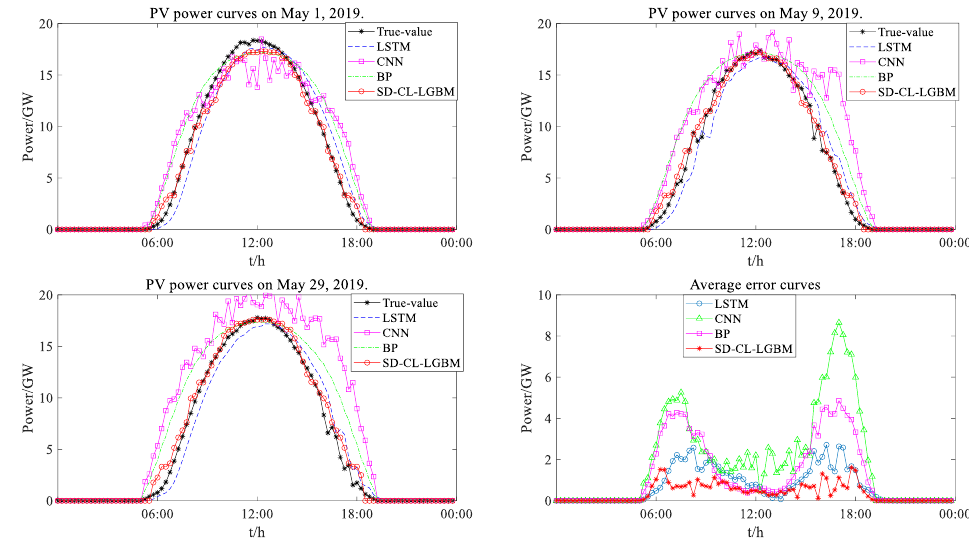
Figure 12. Comparison of prediction results of different models for sunny target days.